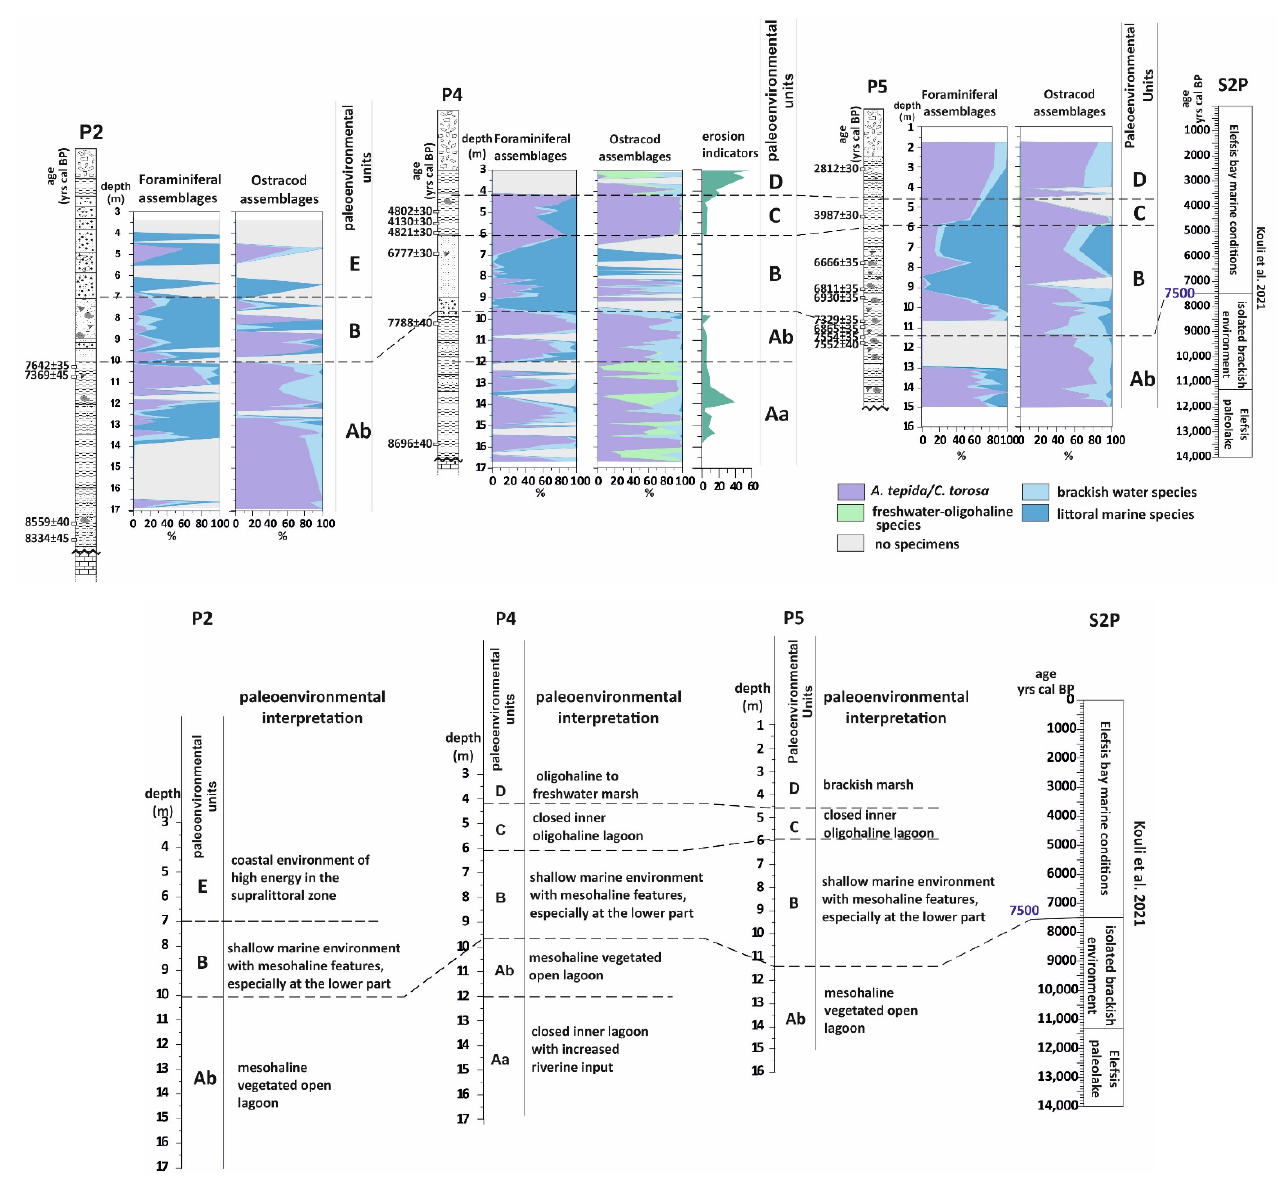
Figure 7. Distribution of foraminiferal and ostracod assemblages along the studied P2, P4, P5 boreholes and intercomparison of the recorded paleoenvironmental changes. Correlation with the paleoenvironmental interpretation of the marine core S2P from Elefsis Bay, is indicated [83]. Paleoenvironmental units Aa–E are separated by dotted lines.